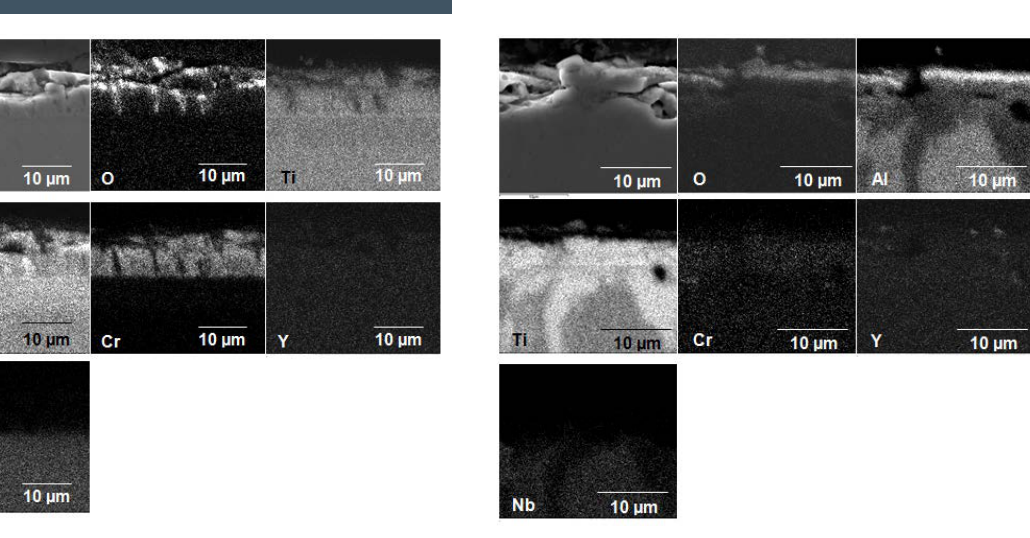
were not observed.